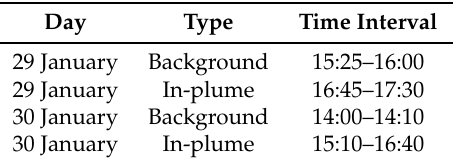
Table 1. Dates and time intervals for the background and in-plume observation sessions. All times are